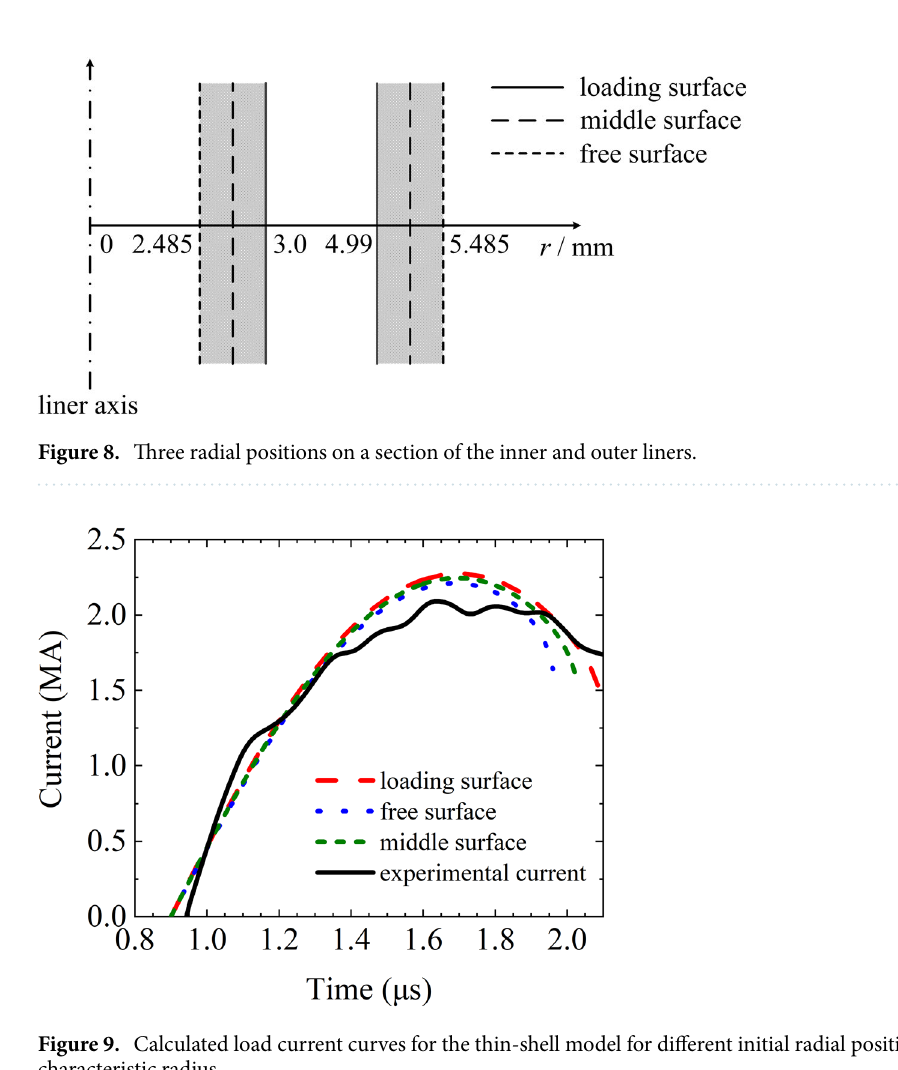
Table 1. Calculation parameters of the thin-shell model.